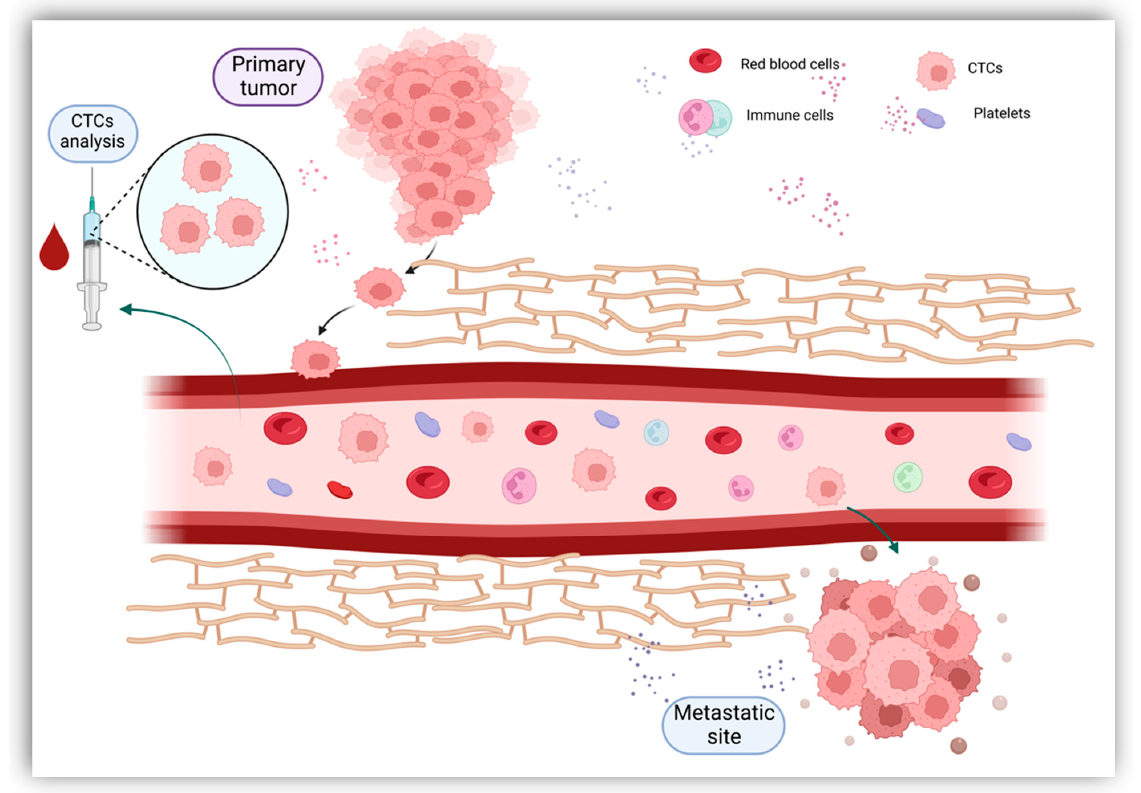
Figure 2. CTCs mechanism of disease dissemination. CTCs derive from the primary tumor, metas- tases and recurrence sites. Once they have entered the bloodstream, CTCs can metastasize in secondary sites. By collecting blood samples, CTCs are examined to offer an in-depth description of the disease.